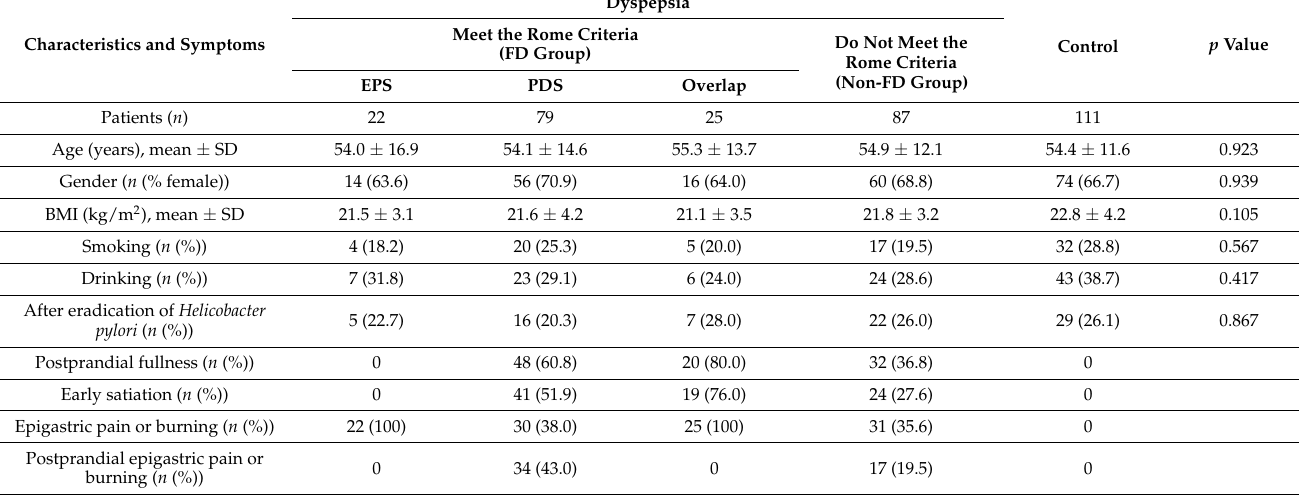
Table 1. Characteristics and symptoms of the patients.